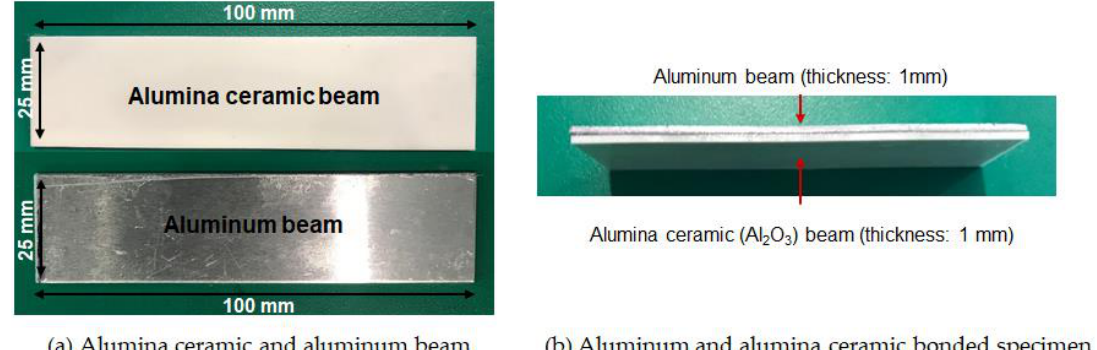
Figure 10. Aluminum and alumina ceramic bonded specimen.